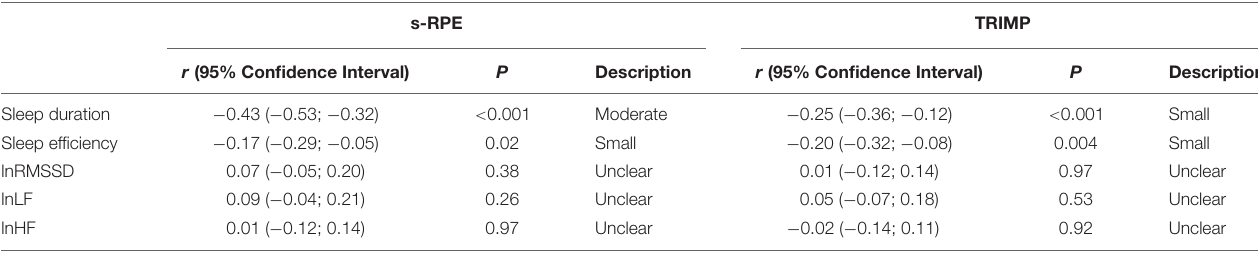
TABLE 2 | Within-subject correlation between sleep and nocturnal heart rate variability indices with session-rating of perceived exertion (s-RPE) and training impulse (TRIMP) during the 14 days of in-season competitive phase ( n = 34). s-RPE